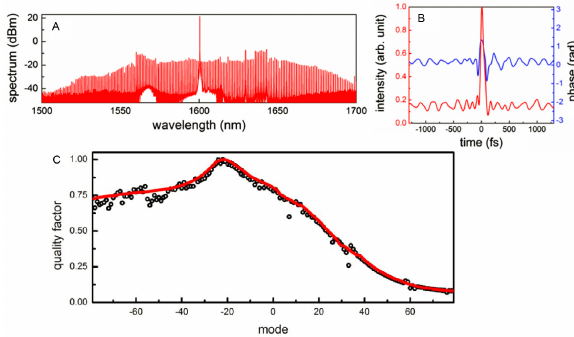
Figure 20: Bright pulse generation from a Si 3 N 4 microring with wavelength-dependent Q factors. (A) Optical spectrum. The comb line spacing is ~115 GHz. (B) Time-domain waveform at microring through port measured with FROG. (C) Loaded Q factors (in million- scale). Larger mode numbers correspond to shorter wavelength. Adapted from Ref. [48].